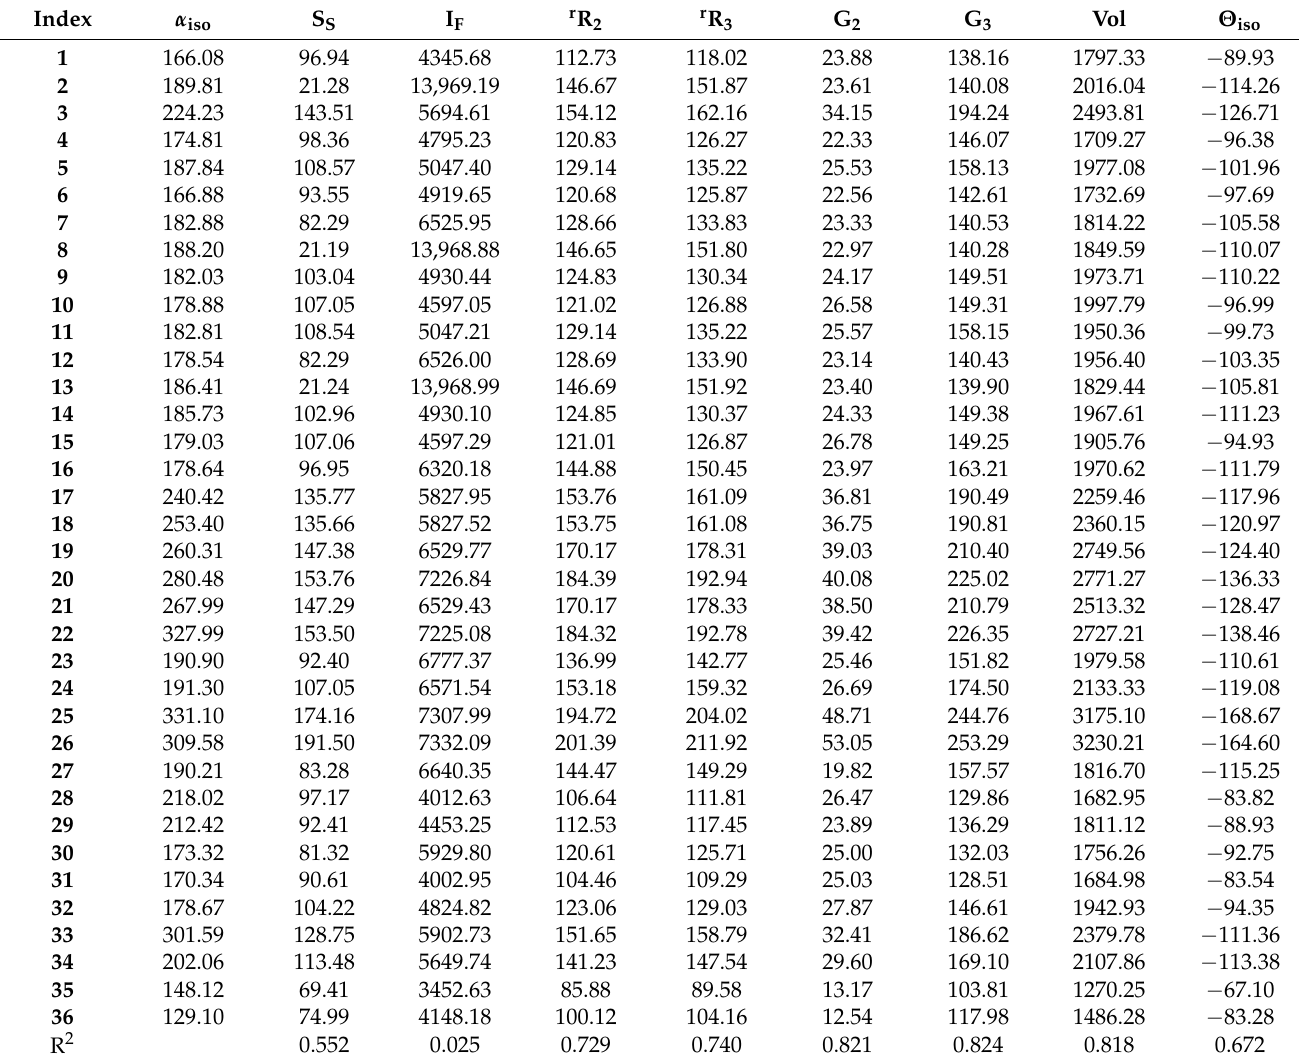
Table 2. Correlation coefficients (R 2 ) between the isotropic molecular polarizability ( α iso , in Bohr 3 ) and ITA quantities (in a.u.), molecular volume (Vol, in Bohr 3 /mol), and the isotropic quadrupole moment ( Θ iso , in a.u.) at S 1 for all the systems in Schemes 1 and